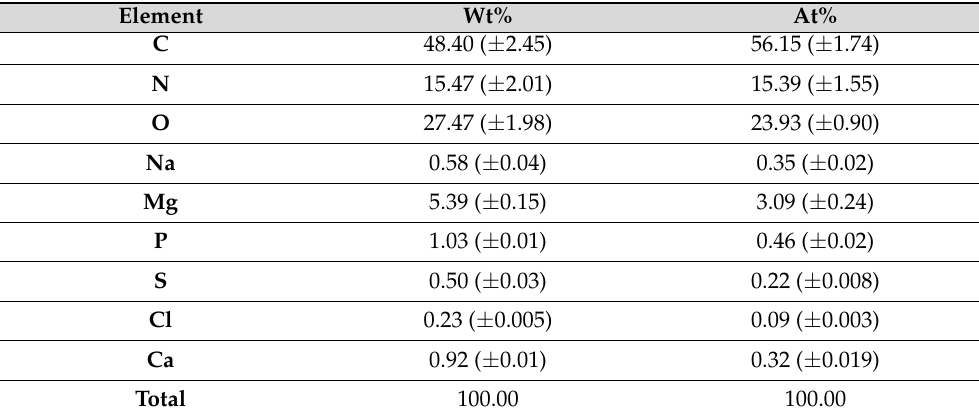
Table 1. Elemental composition of S. hermaphrodita seed extract determined after excitation of the preparation with a 10 kV beam. Wt%—weight percentage of a given element in the sample; At%— atomic percentage of a given element in the sample. The results presented are the mean of three independent measurements.